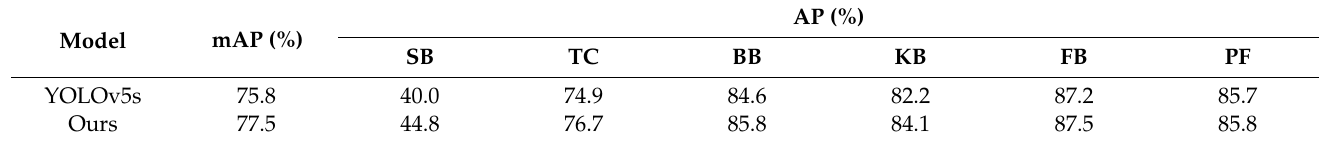
Table 4. Comparative experimental results of the improved model and the YOLOv5s model.